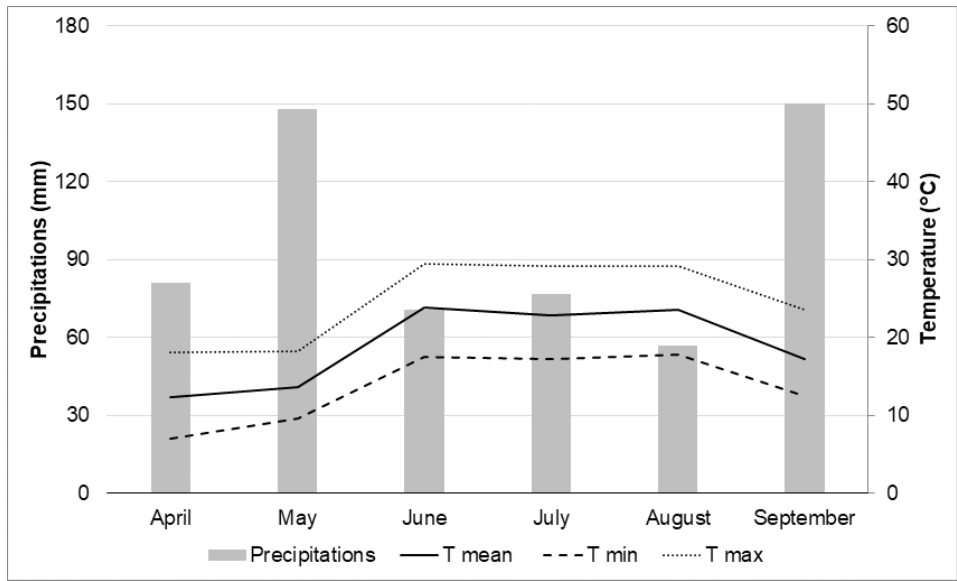
Figure 1. Walter climate diagram with the sum of precipitation and air temperature conditions during the experiment (Zagreb, Croatia). T min—minimum air temperature; T max—maximum air temperature; T mean—mean (average) air temperature. Table 1. Chemical and physical soil properties at the experimental station. Table 2. Treatments used in the